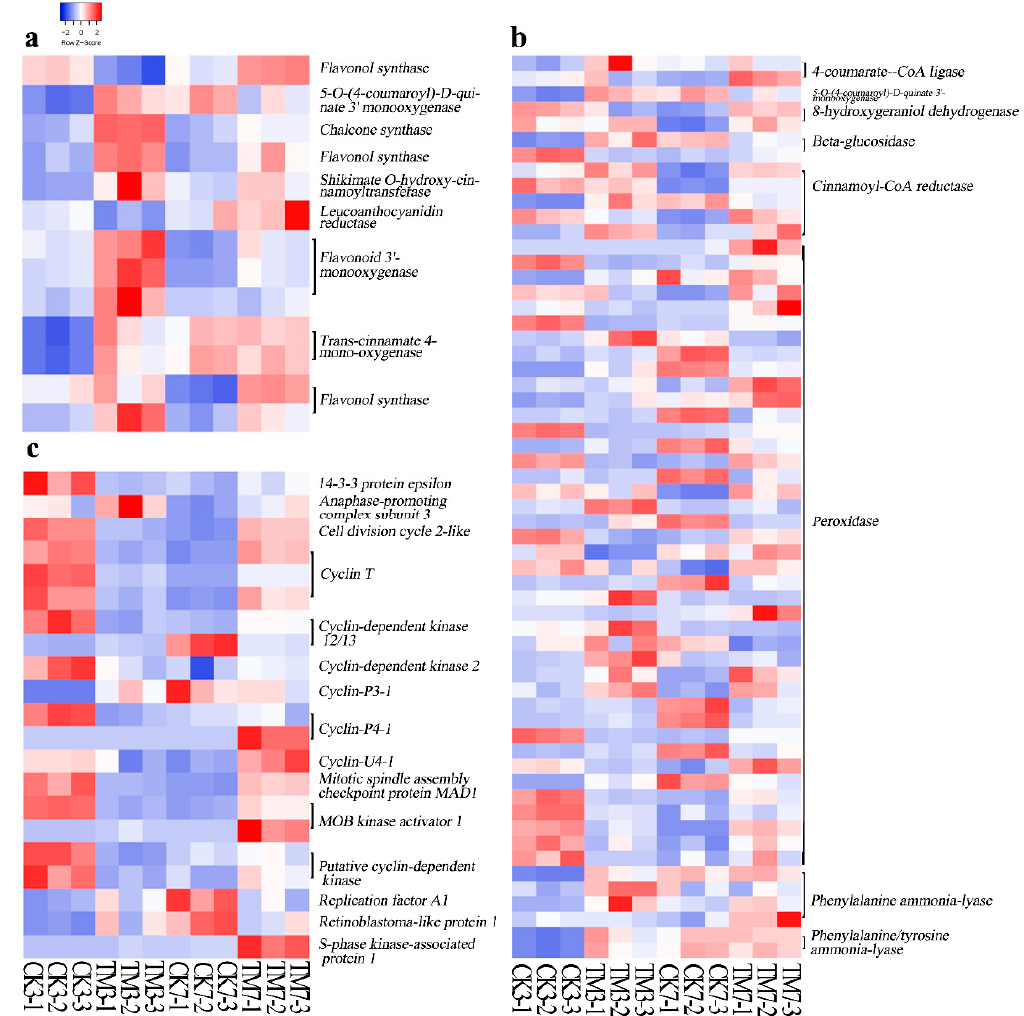
Figure 4. Heat map of DEGs related to flavonoid biosynthesis, phenylpropanoid biosynthesis, and the cell cycle. ( a ) Flavonoid biosynthesis, ( b ) phenylpropanoid biosynthesis, ( c ) the cell cycle. The color key represents log2-transformed fold changes: red indicates high expression, while blue represents low expression. Heat map representing transcripts per million (TPM) expression from RNA-seq. The Z-score scale is shown in the top-left corner, and it ranges from red to blue.